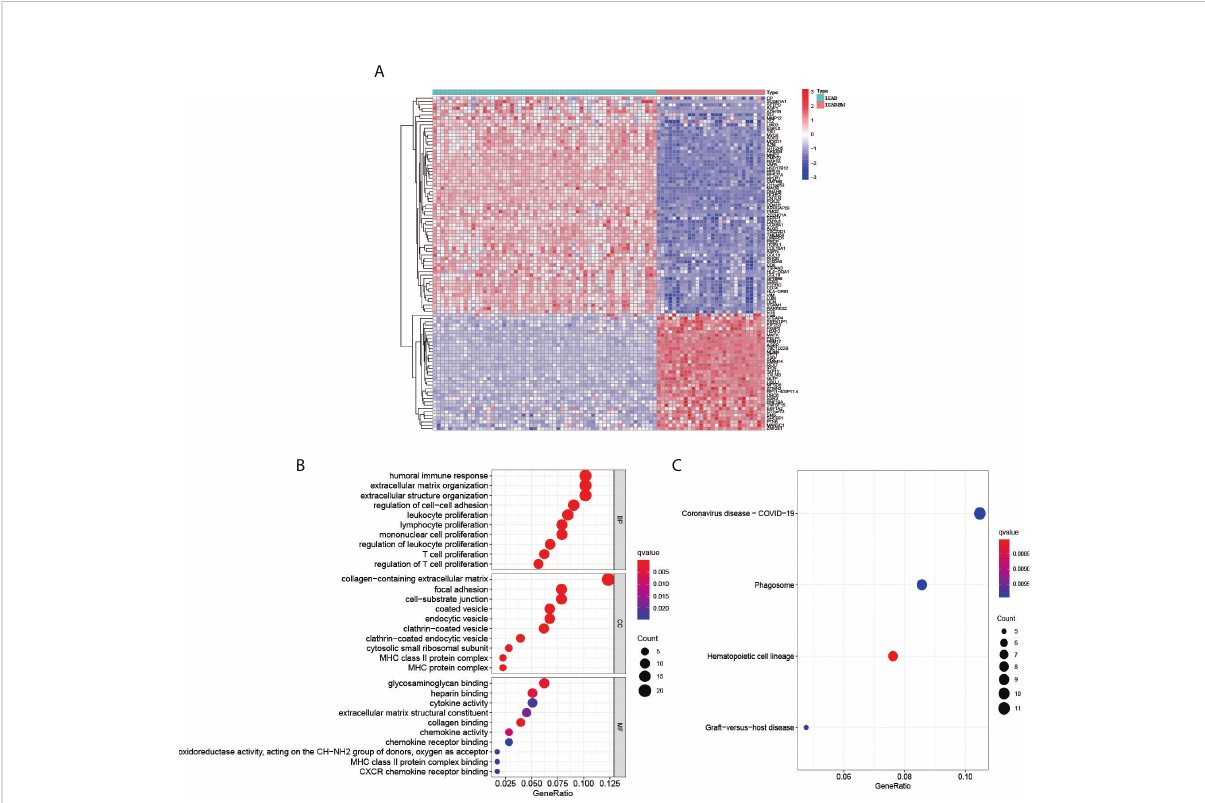
FIGURE 1 Analysis the differential genes between LUAD and LUAD-BM. (A) Heatmap of LUAD and LUAD-BM (|log2FC| ≥ 2, p < 0.05). The GO biological function analysis (B) and KEGG pathway analysis (C) of